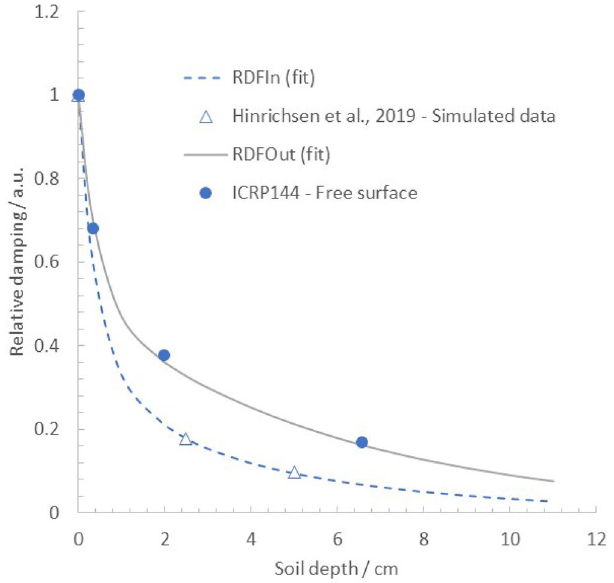
Figure 2. Relative damping factor, RDF (RDF in = indoor occupancy and RDF out = outdoor occupancy ) , of air kerma rate 1 m above ground level as a function of burial depth of 137 Cs deposition obtained from fitting bi-exponential decay functions to simulated data provided from 19 and 21